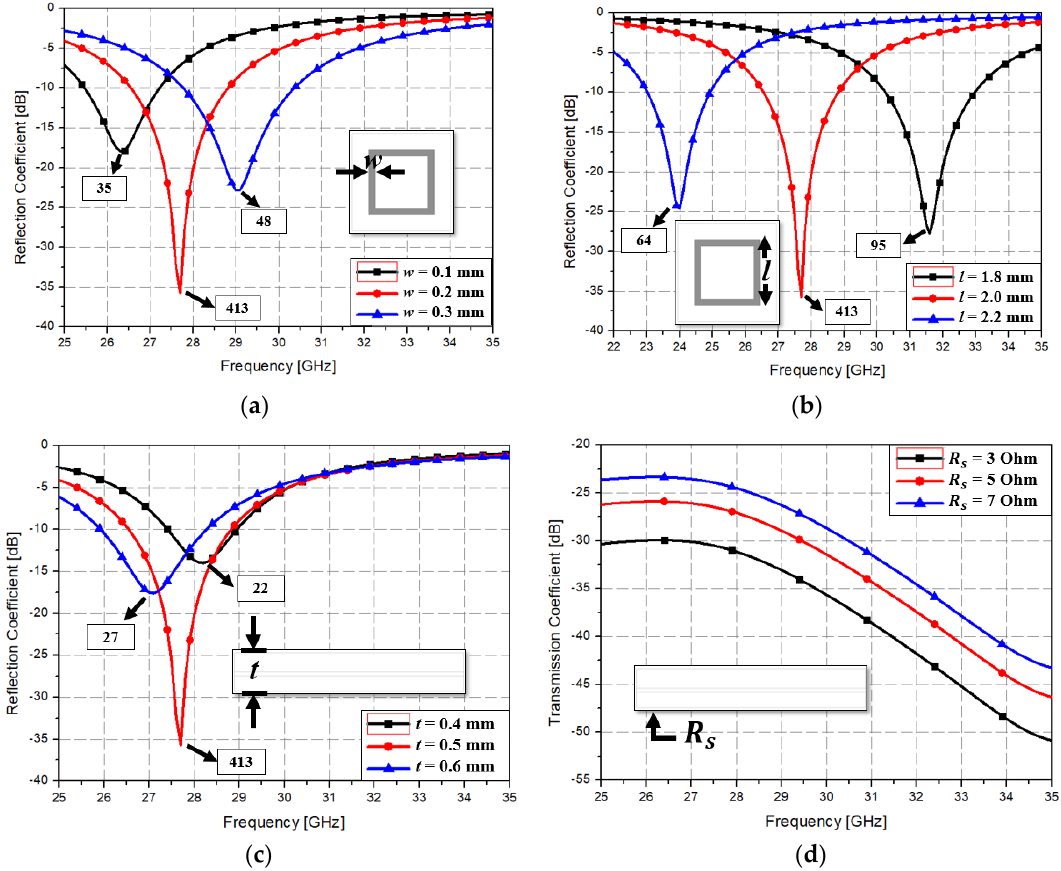
Figure 2. Plot of simulated S-parameters versus frequency for different values of parameters: ( a ) width of the square conductive loop, ( b ) length of the square conductive loop, ( c ) thickness of the unit cell, and ( d ) resistivity of the bottom ground plane.